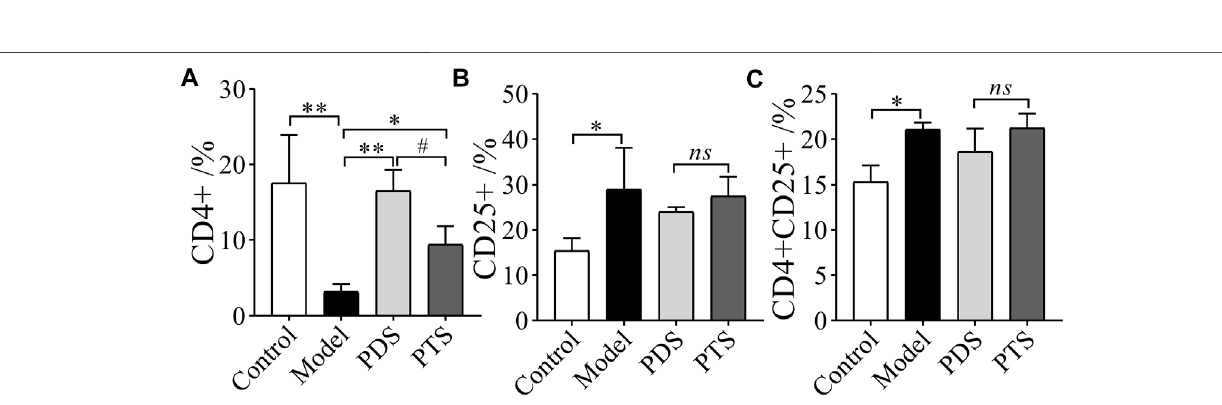
FIGURE10| TheeffectsofPDSandPTSonT-lymphocytesinmyelosuppression mice. (A) CD4 + ; (B) CD25 + ; (C) CD4 + CD25 + .Thedataareexpressed asmean± SD ( n = 3), * p < 0.05 and ** p < 0.01 compared with the model group; # p < 0.05 compared with PTS group, ns showed no signi fi cance between the two